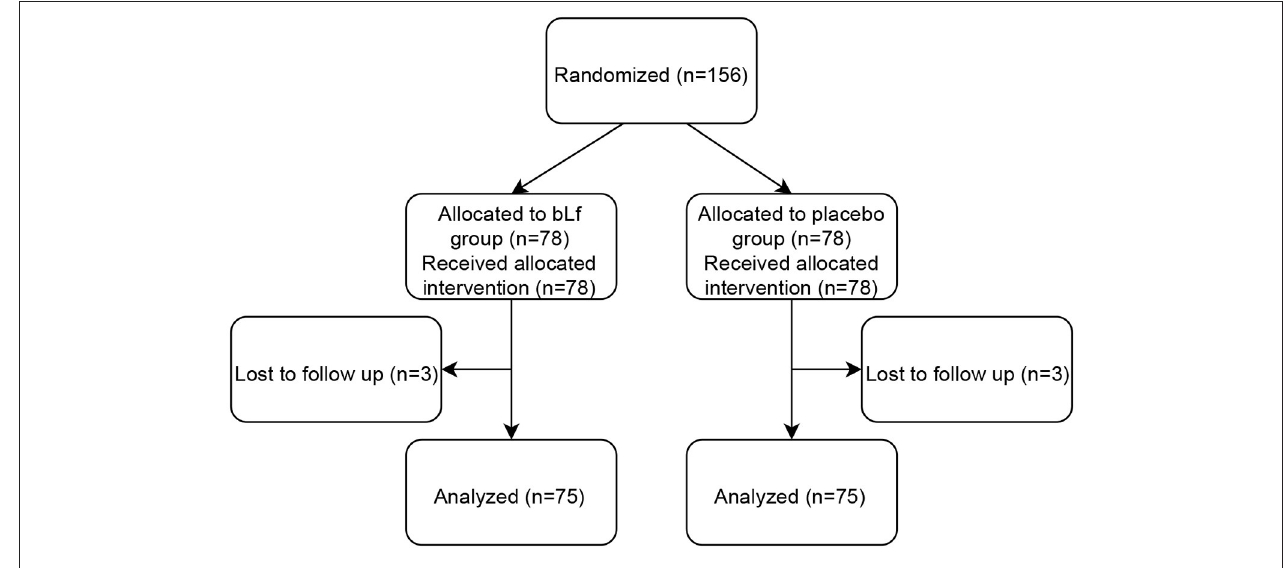
FIGURE 1 | Patient study flow diagram.